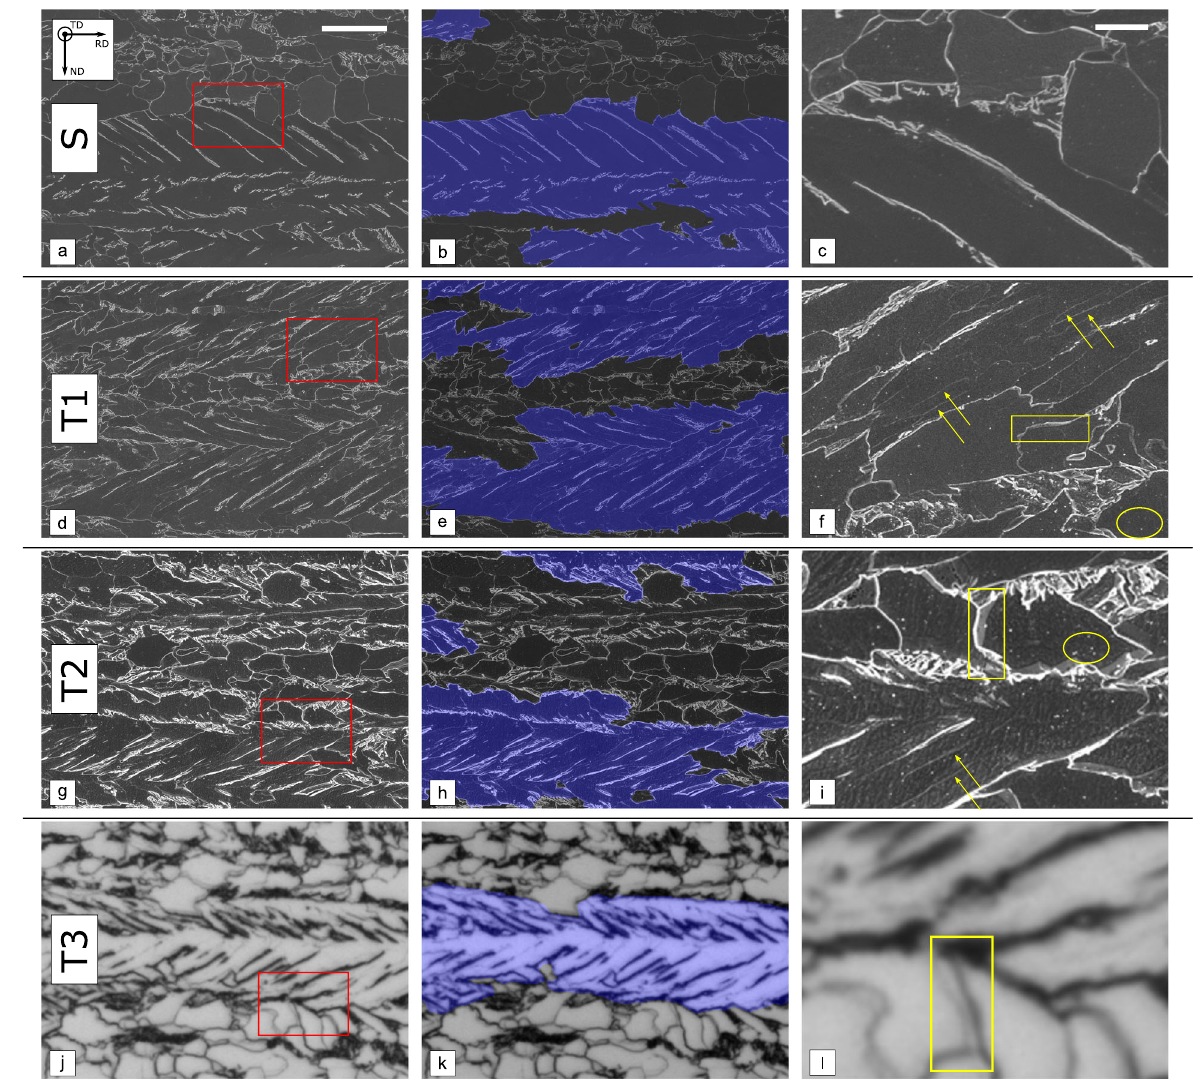
Fig. 1 Visualization of the investigated micrograph sets. Input images, same superimposed with the annotation, and a detail view are each shown for the source ( a – c ), target 1 ( d – f ), target 2 ( g – i ), and target 3 ( j – l ) domain. Please refer to Table 6 for the technical details about the different sets. The red frames in the fi rst column highlight the region of interest shown in the third column. Yellow annotations are used in the section “ Dataset processing ” for discussing major differences between the domains. The scale bar in ( a ) applies to the fi rst and second column and its width corresponds to 10 μ m, while the third column scale bar width amounts to 2 μ